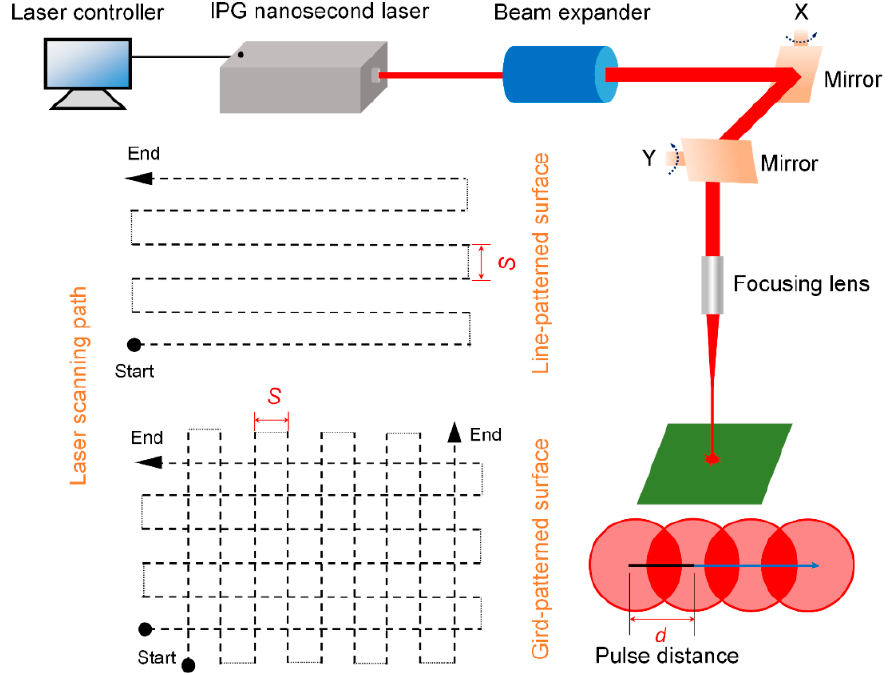
Figure 1. Laser system components and schematic explanation of laser pulse distance.